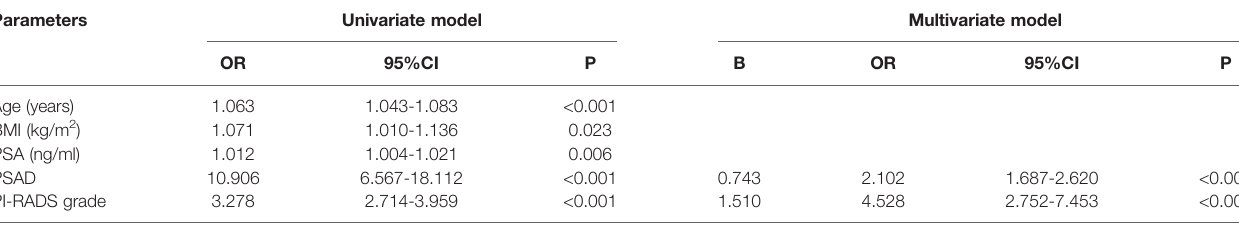
TABLE 2 | Univariate and multivariate analysis for screening the predictors of outcomes (PCa) of prostatic biopsy.